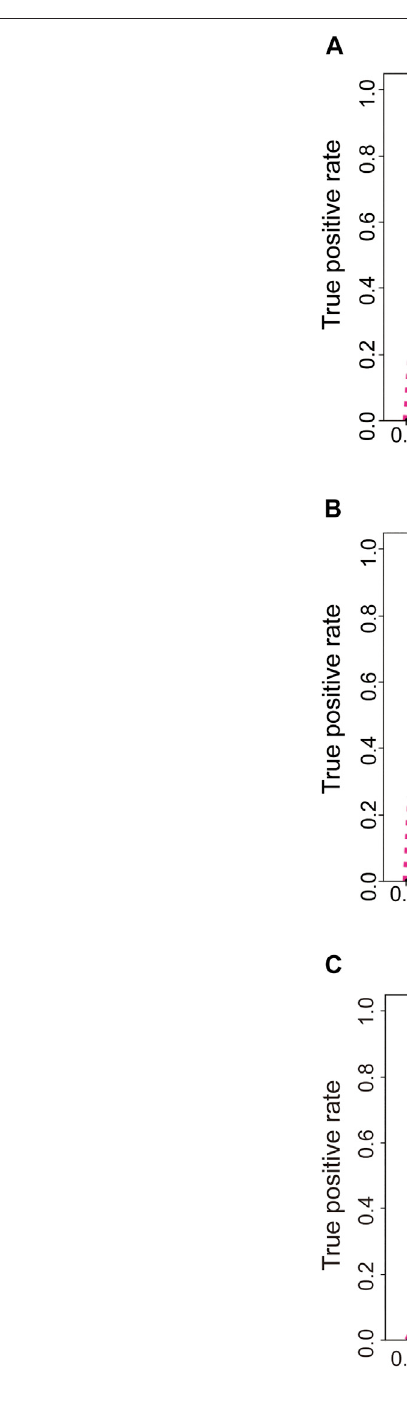
Frontiers in Physiology |